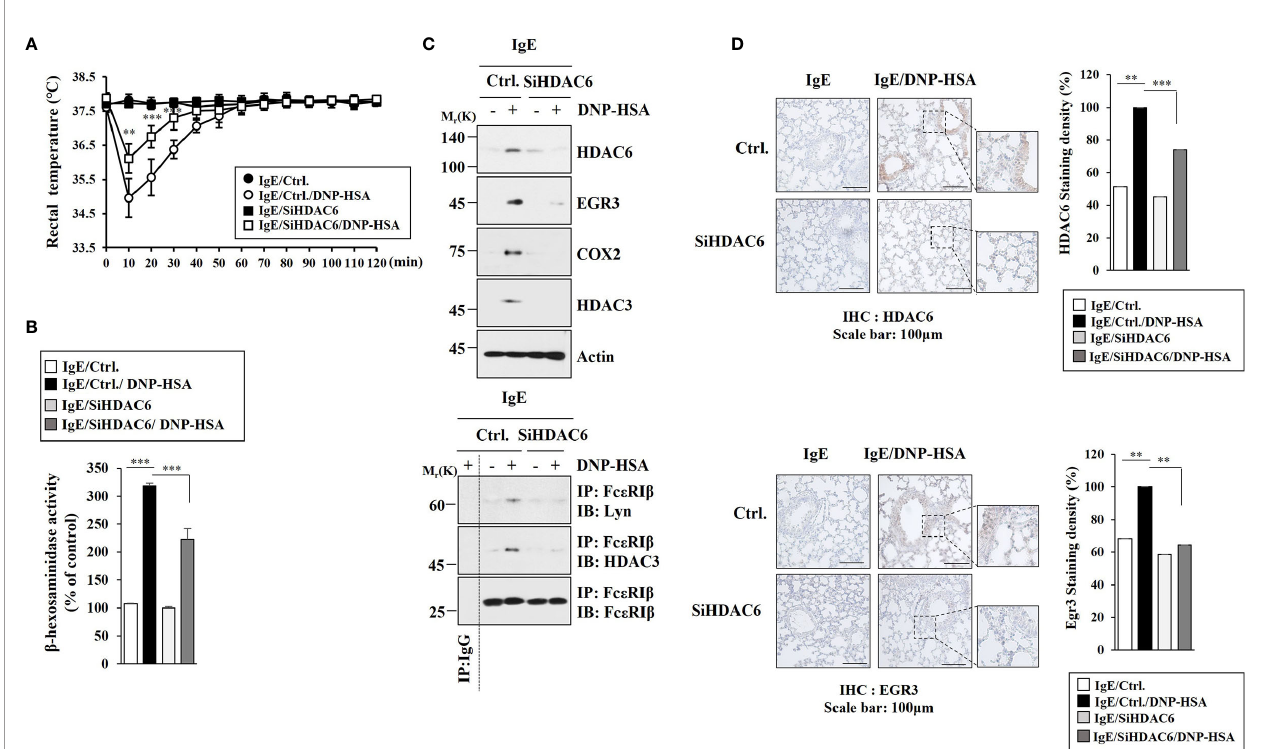
FIGURE 4 | HDAC6 mediates passive systemic anaphylaxis. (A) BALB/C mice were intravenously injected with the indicated siRNA (each at 3 m g/kg). Each experimental group comprised fi ve mice. The means ± S.E. of three independent experiments are depicted. ** p <0.01, compared with IgE/Ctrl./DNP-HSA; *** p <0.001, compared with IgE/Ctrl./DNP-HSA. (B) The b -hexosaminidase activity assays were performed. *** p <0.001. The data are expressed as mean ± SE of results from four mice of each experimental group. Average values of three independent experiments are shown. (C) Immunoblot and immunoprecipitation employing lung tissue lysates were performed (n=4). Representative blots of three independent experiments are shown. (D) Immunohistochemical staining employing lung tissue was performed. Representative images of the staining are shown (n=3). Quanti fi cation was performed using Image J (NIH). ** p <0.01; *** p